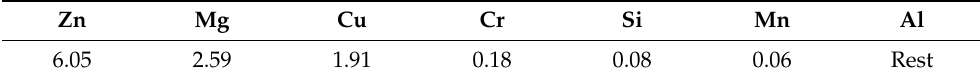
Table 1. Chemical composition of the tested alloy (weight%).